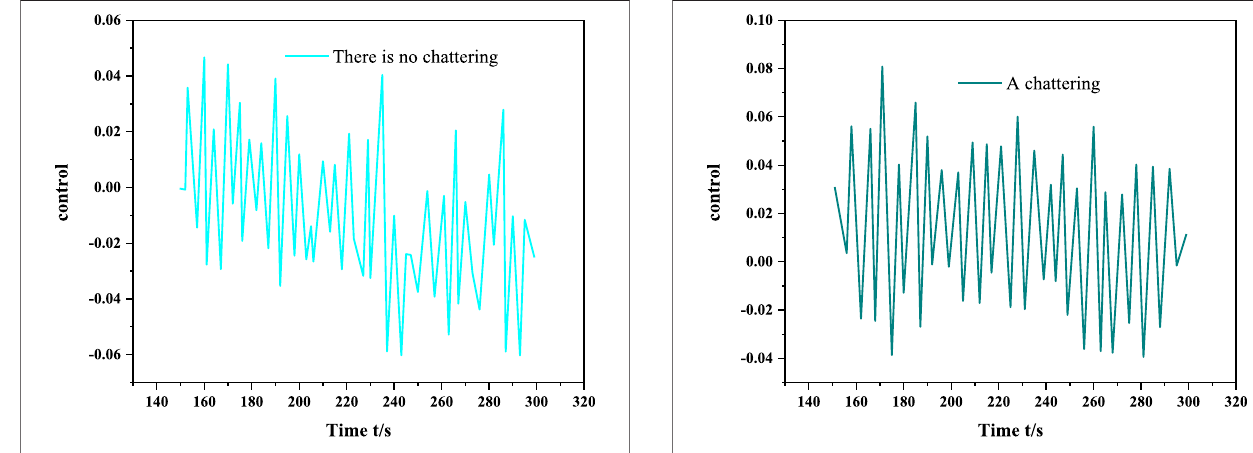
FIGURE2| Slidingmodecontrolwithtargettrajectory r =1.2+0.1sin( t ).